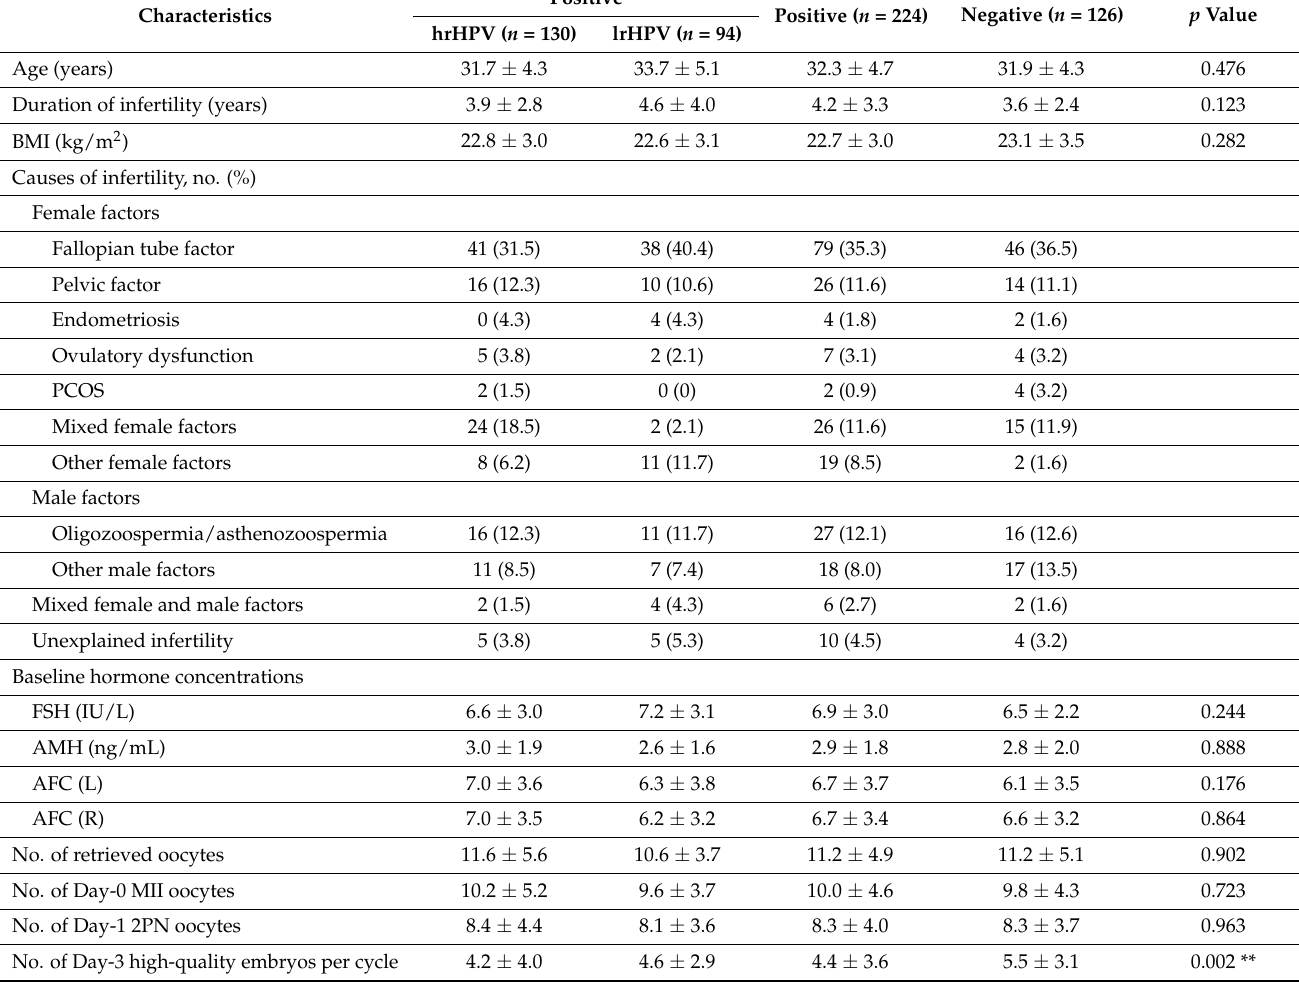
Table 1. Characteristics of infertile women patients who underwent IVF/ICSI-ET